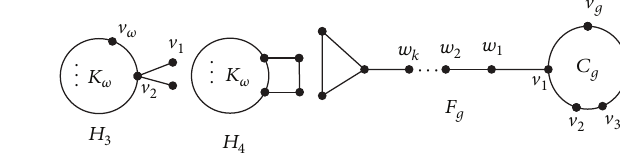
Figure 7: Graphs 𝐻 3 , 𝐻 4 , and 𝐹 𝑔